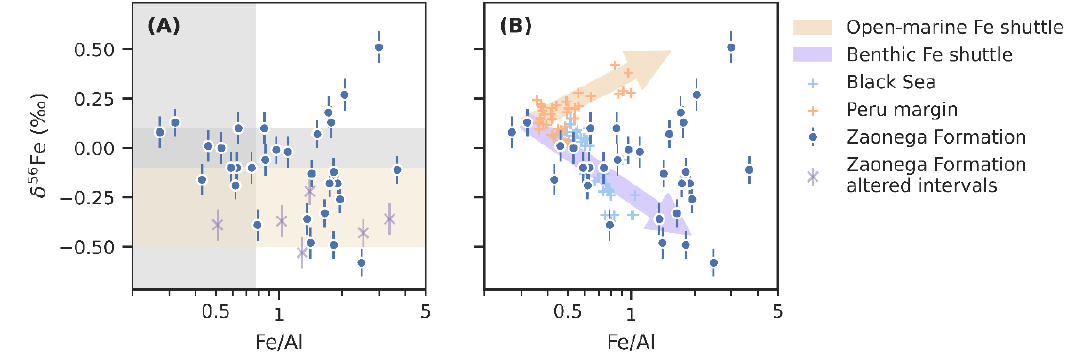
Figure 4. Iron isotope values from the Zaonega Formation plotted against Fe/Al ratios, a proxy for both the diagenetic loss of Fe and authigenic Fe input (notice the logarithmic scale on the horizontal axis). Panel ( A ) shows the data against typical crustal Fe/Al ratios (vertical grey span) [35], and δ 56 Fe range (grey horizontal span) [100], as well as the hydrothermal δ 56 Fe range (yellow horizontal span) [101,102]. Purple cross symbols are data from silicified intervals [15]. Panel ( B ) presents an interpretation in which the trends in δ 56 Fe values are explained through a benthic Fe shuttle (similar to the Black Sea) [38], and an open-marine authigenic Fe shuttle component (similar to the Peru margin) [66].